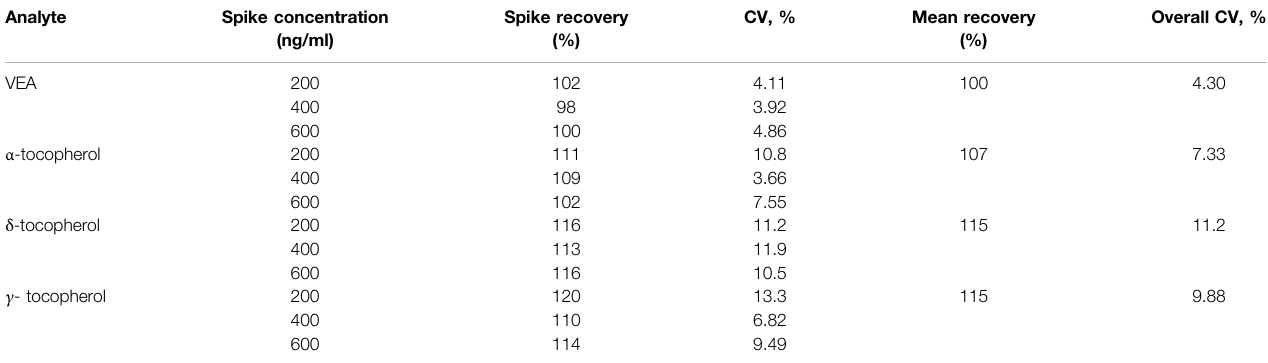
(based on six replicates for each spike level).